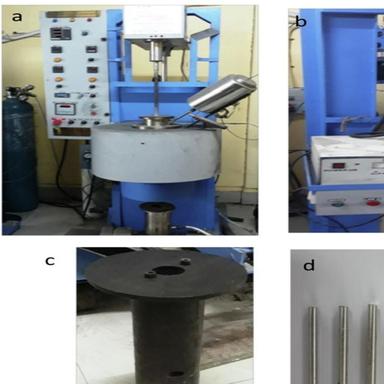
Pictorial view of Ultra Sonic stir casting unit (a) Stir casting unit, (b) Ultrasonic vibration unit, (c) Split type die, (d) Cylindrical samples.